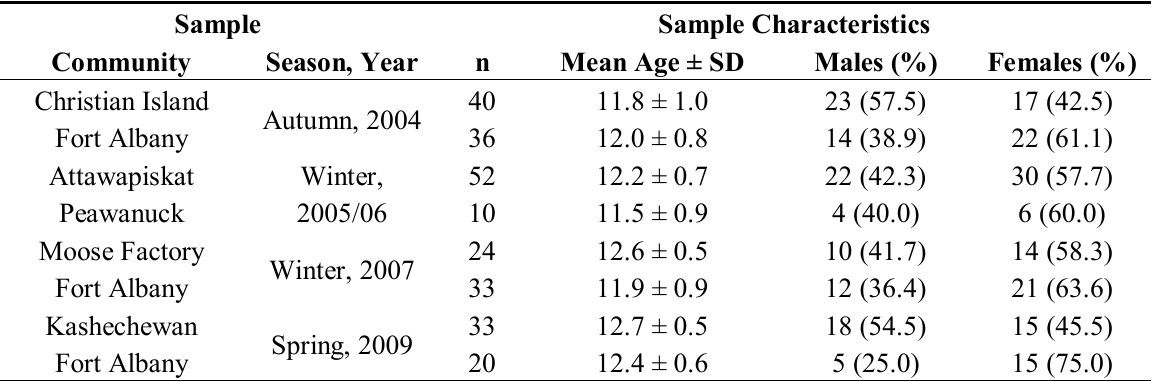
Table 5. Characteristics of participants in the comparison of dietary intakes by community. Sample Sample